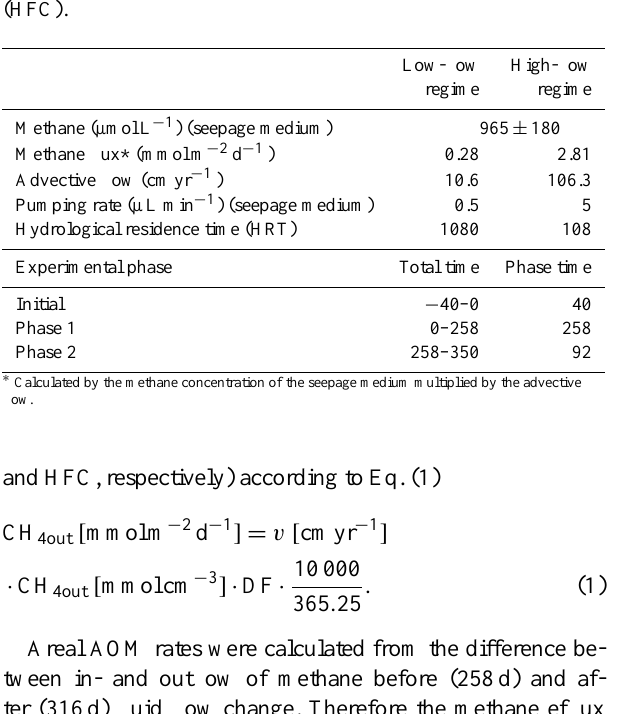
Table 4. Overview of conditions during SLOT experiments: methane concentration of the “seepage” medium, methane flux, ad- vective flow, and pump rate in the low- and high-flow core as well as experimental phases and run times under the low- and high-flow regime. The length of the sediment cores was 15 (LFC) and 14cm